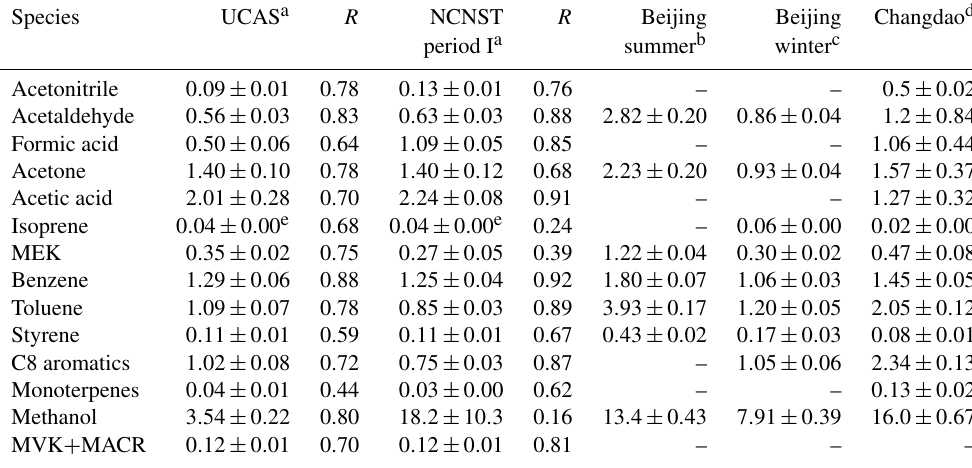
Table 2. VOC emission ratios to CO at the urban and suburban sites and comparison with other studies.